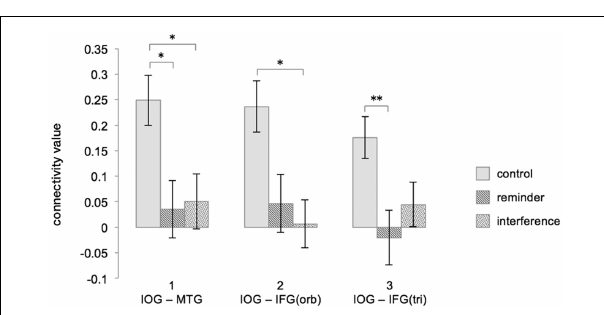
FIGURE 5 | Interferences and reminders disrupt FC increase during post-encoding rest ( (cid:49) FCR3 – FCR1). Depicted are combinations of brain regions showing a significant FC increase during undisturbed post-encoding rest in the control condition and how the different modulations change FC in the ROI-to-ROI analysis. Column 1 refers to the FC between the right IOG/fusiform gyrus and the left MTG, column 2 refers to the FC between the right IOG/fusiform gyrus and the orbital part of the left IFG, and column 3 refers to the FC between the right IOG/fusiform gyrus and triangular part of the left IFG. Connectivity values represent fisher-transformed correlation coefficients. Significant differences are marked with an asterisk at p < 0.05 and with two asterisks at p < 0.01 (Bonferroni-corrected). Error bars depict the standard error. FC, functional connectivity; C, control; RE, reminder; IN, interference; IOG, inferior occipital gyrus/fusiform gyrus; MTG, middle temporal gyrus; IFG, inferior frontal gyrus; orb, orbital; tri,